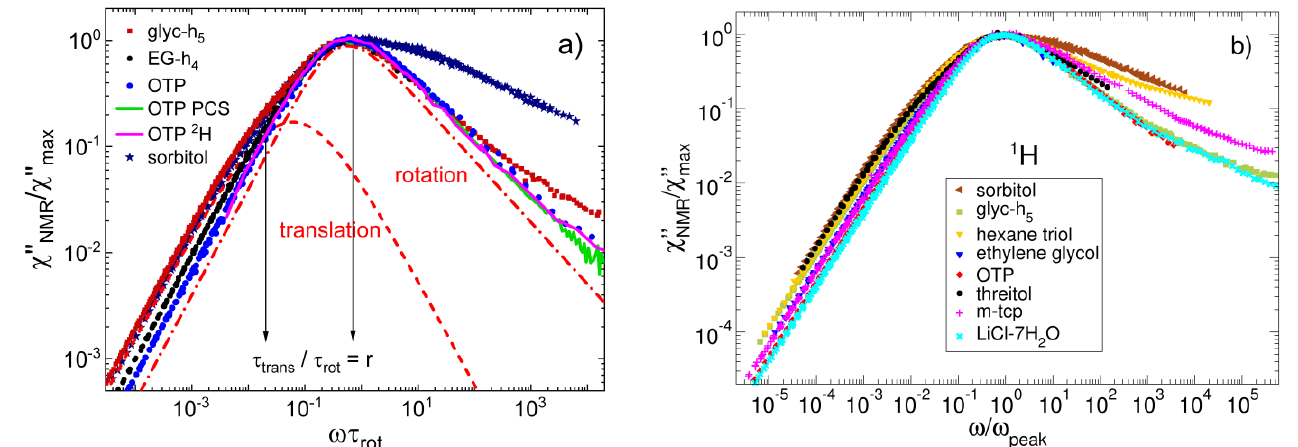
Figure 4. ( a ) NMR susceptibility master curves of o-terphenyl (OTP), ethylene glycol-h 4 (EG-h 4 ) [84], glycerol-h 5 (glyc-h 5 ), and sorbitol scaled to overlap in the peak region [85]; the r value characterizing the separation of translational and rotational time constants increases from 10 (o-terphenyl) to 26 (ethylene glycol) to 54 (glycerol and sorbitol). In the case of o-terphenyl, the susceptibilities obtained from 2 H relaxation [86] and from DLS [87] are included. ( b ) FC susceptibility master curves of the eight liquids studied so far.